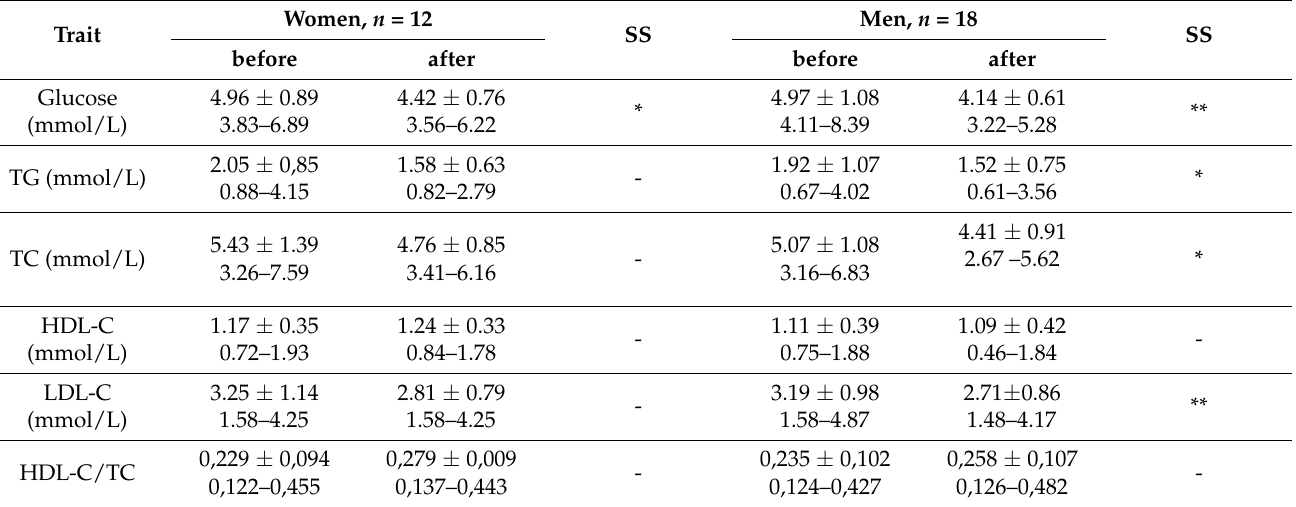
Table 6. Impact of diet correction on selected parameters of carbohydrate–lipid metabolism, DPS − patients suffering from schizophrenia; x ± SD,